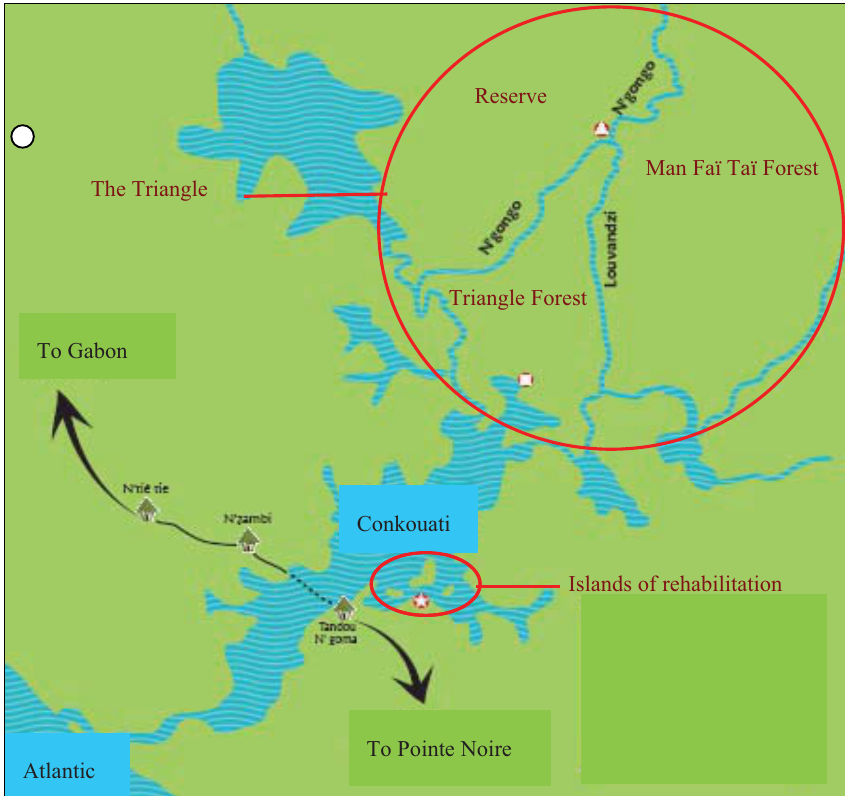
Figure 1. Map of the release site Triangle within the sanctuary of HELP Congo (the release site so called the “Triangle” of 22 km² area, is composed of three sites, the Triangle forest, the Man Faï Taï forest and the Reserve. Chimpanzees are free ranging, using natural bridges to cross the